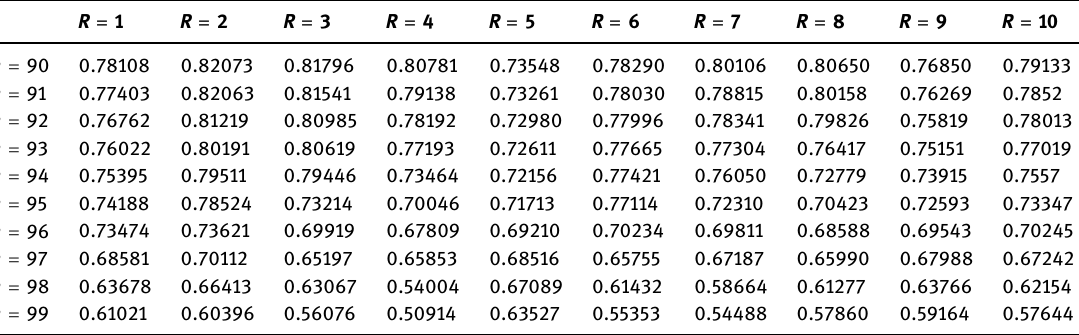
Table 5: Average of sample of all G i values of test after removing the maximum values satis fi es the alternative hypothesis that there are at most r outliers: the mean